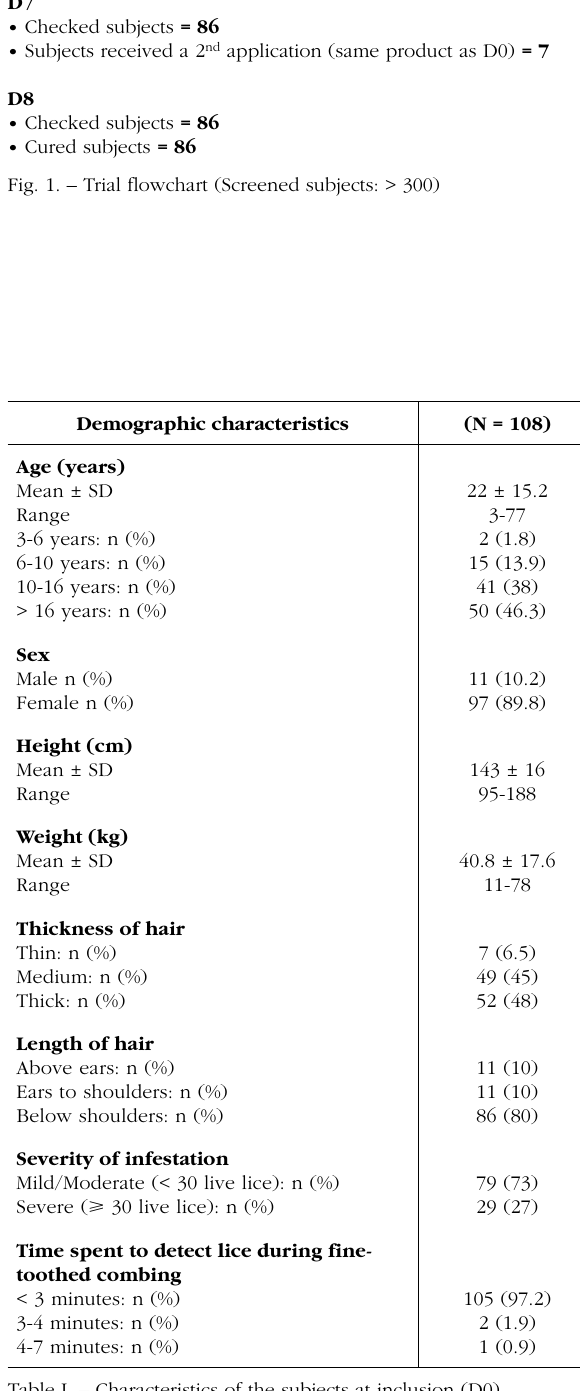
table I. – characteristics of the subjects at inclusion